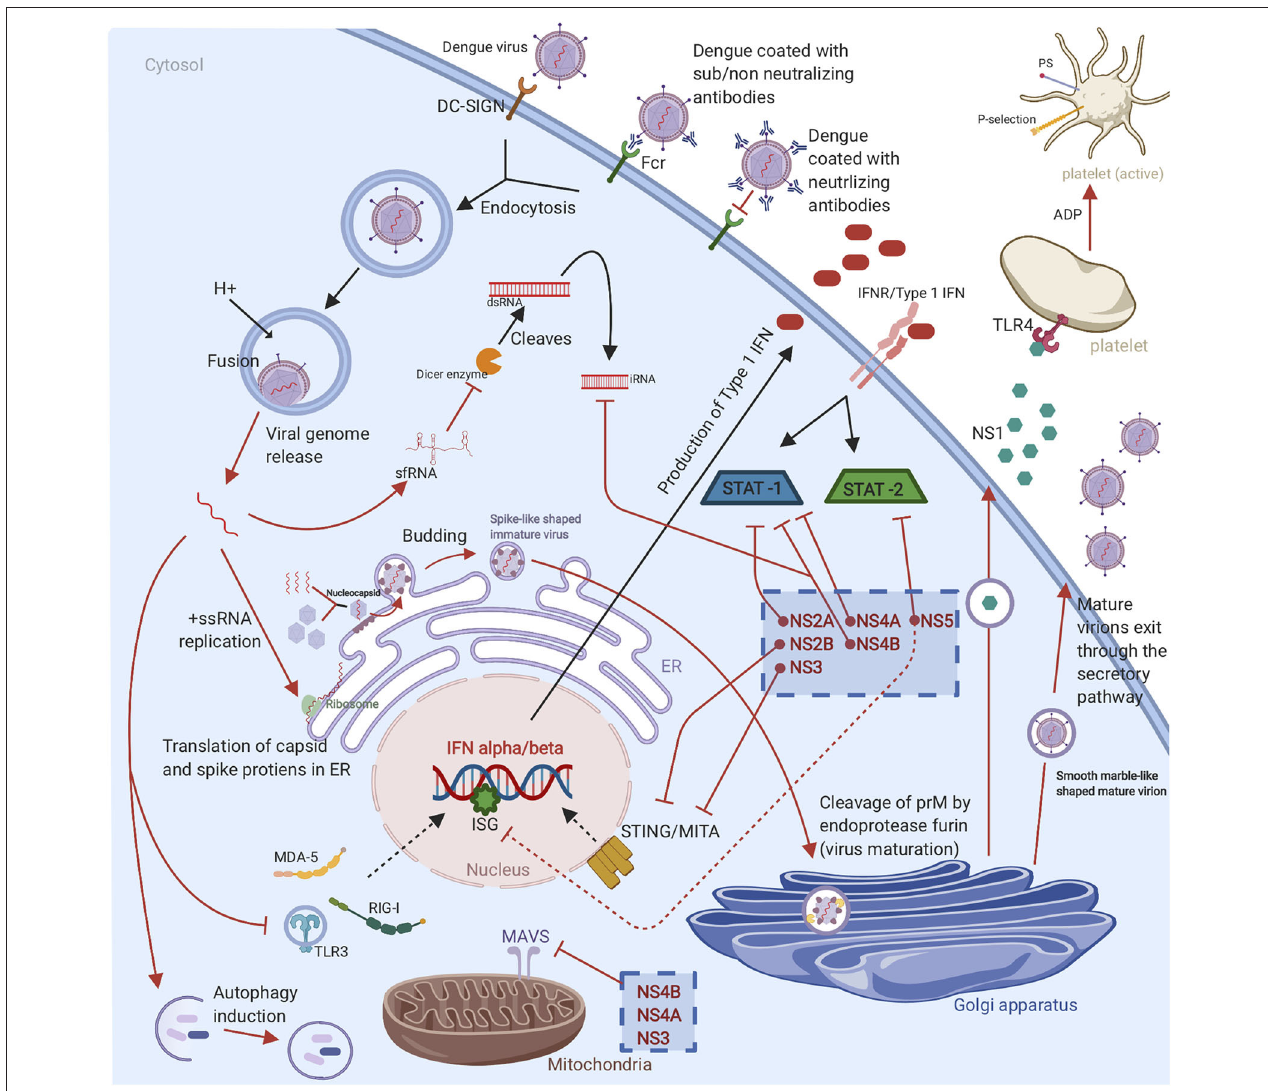
FIGURE 2 | Graphical representation of DENV life cycle and subversion of the innate immune response: The virus enters the host cell through receptor mediated endocytosis or antibody dependent enhancement. Once the virus is endocytosed, the viral RNA escapes the endosome, followed by RNA translation in ER and replication in cytoplasm. Then the newly replicated viral genome is assembled with the C protein to form a nucleocapsid which buds into ER to obtain a lipid membrane coated with prM/M and E proteins. The virion bunds out of ER as immature virion which is characterized by spiky appearance. For further maturation, the virion travel to Golgi apparatus where the prM protein is cleaved by the cellular endoprotease furin to form a mature virion which exists the cell through secretory pathways and infect new cells. The non-structural proteins (NS1, NS2A, NS2B, NS3, NS4A, NS4B, and NS5) of DENV have various evasion mechanisms. These evasion mechanisms include TLR, RIG-I, and MDA5 signaling cascades disruption, suppression of IFN α / β -mediated antiviral responses, MITA/STING cleavage, interference with RNAi response, enhance viral replication by autophagy induction, inhibition the cleavage of double-stranded RNA by Dicer enzyme, suppression the ISGs, inhibition the upstream and downstream of MAVS pathway, STAT1 phosphorylation inhibition, and STAT2 degradation. Finally, the non-structural proteins are able to induce platelet activation, aggregation, and apoptosis that leads to vascular leakage and thrombocytopenia (Red arrows represent various countermeasures that have been developed by dengue to evade and or to hinder antiviral innate immune response. The cellular antiviral response against DENV is indicated with black